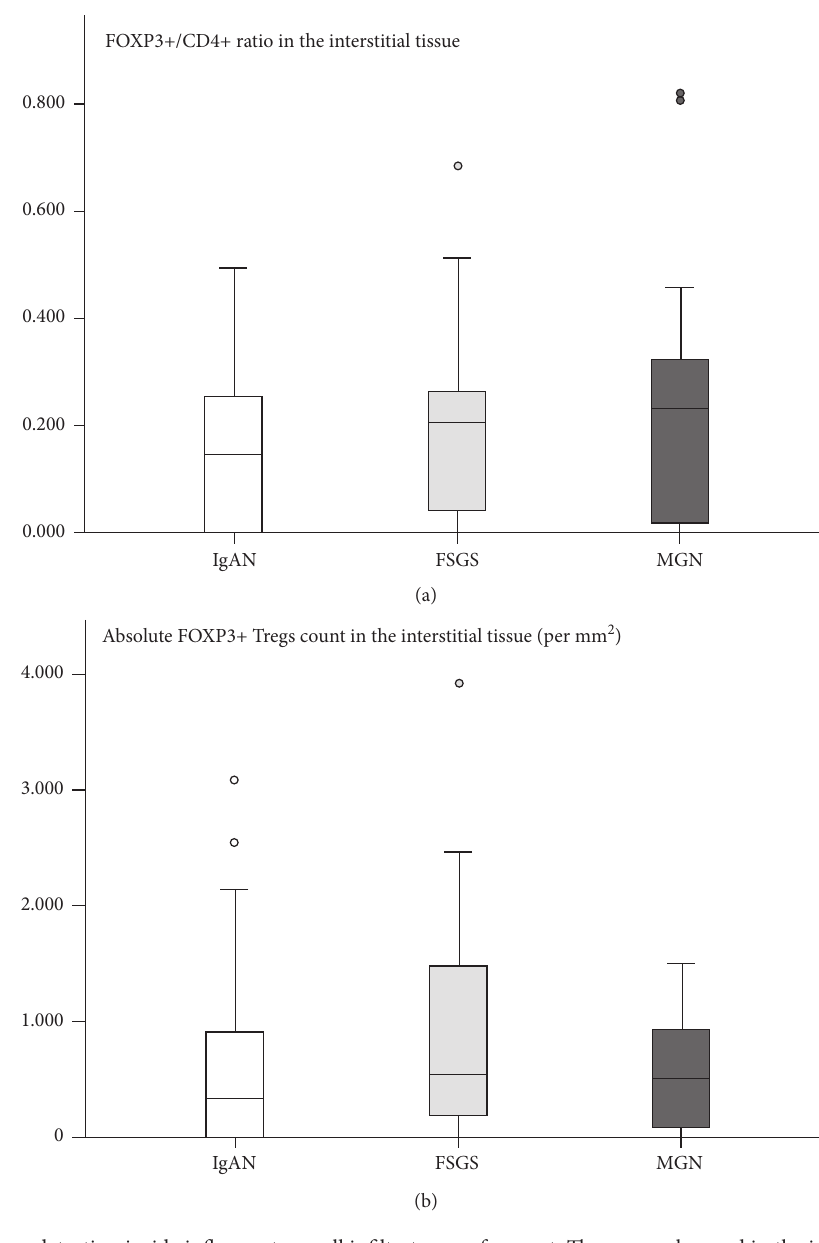
Figure 2: FOXP3+ Tregs detection inside inflammatory cell infiltrates was frequent. They were observed in the interstitial tissue in 64% of patients with IgAN, 77% of patients with FSGS, and 76% of patients with MGN. (a) Comparative diagram of FOXP3+/CD4+ ratio in the interstitial tissue ( p value > 0.05 for all comparisons). No statistical difference was found between the three glomerulopathies in FOXP3+ Tregs over the CD4+ ratio. (b) Comparative diagram of absolute FOXP3+ Tregs count in the interstitial tissue (per mm 2 ; p value > 0.05 for all comparisons). No statistical difference was found between the three glomerulopathies in absolute FOXP3+ Tregs count. FSGS: focal segmental glomerulosclerosis, IgAN: IgA nephropathy, MGN: membranous glomerulopathy, and Tregs: regulatory T